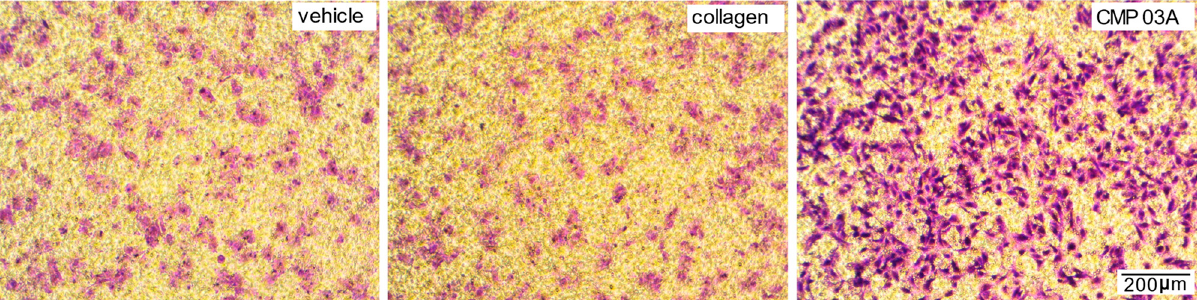
Figure 3. CMP promotes migration and adherence of ARPE-19 cells in transwell assay. Cresyl violet-stained ARPE-19 cells migrating and adhering to the pre-coated basal (distal) side of transwell membranes, following application of cells to the apical side only. Migration and adherence appeared significantly higher for basal surfaces coated with CMP 03A. Scale in lower right panel applies to all images.